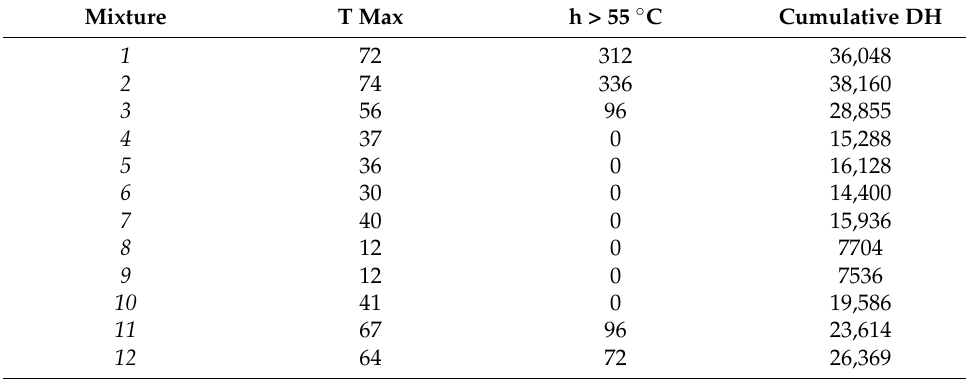
Figure 1. Temperature profiles during the active phase of composting. Horizontal line indicates 55 °C (1–2: [21]; 10–11: [3]; 12: [3]). Table 3. Temperature parameters during composting.